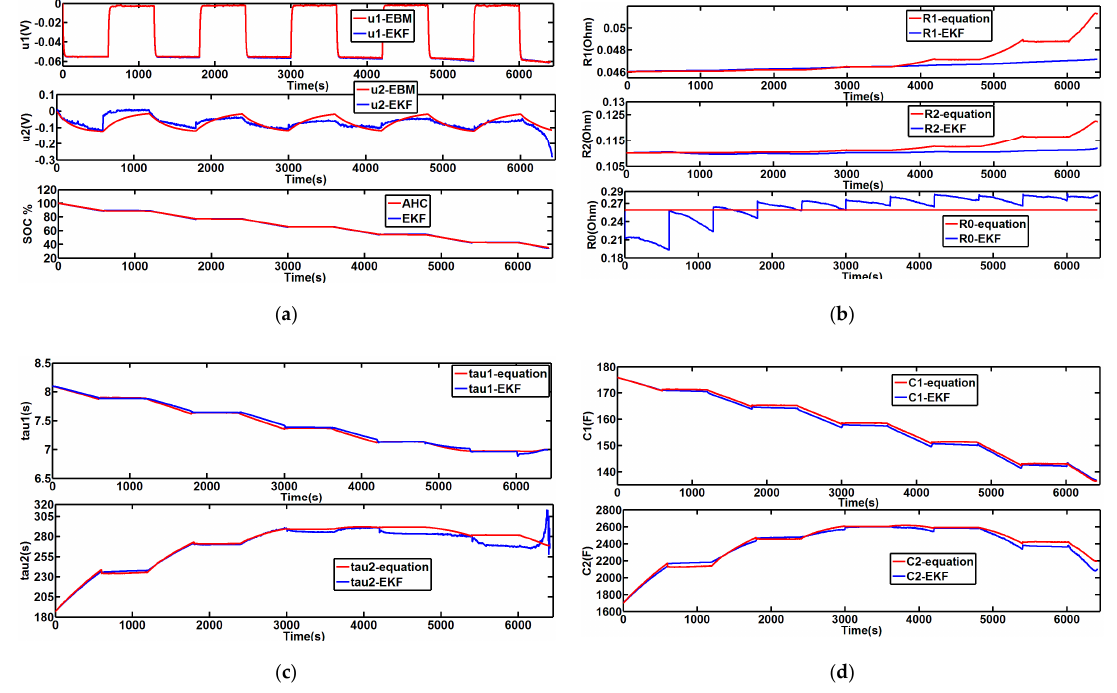
Figure 15. EKF results for 1.2 A current profile ( a ) plot of u 1 , u 2 and SOC, ( b ) resistances R 1 , R 2 and R 0 ( c ) time constants τ 1 and τ 2 ( d ) capacitances C 1 and C 2 .